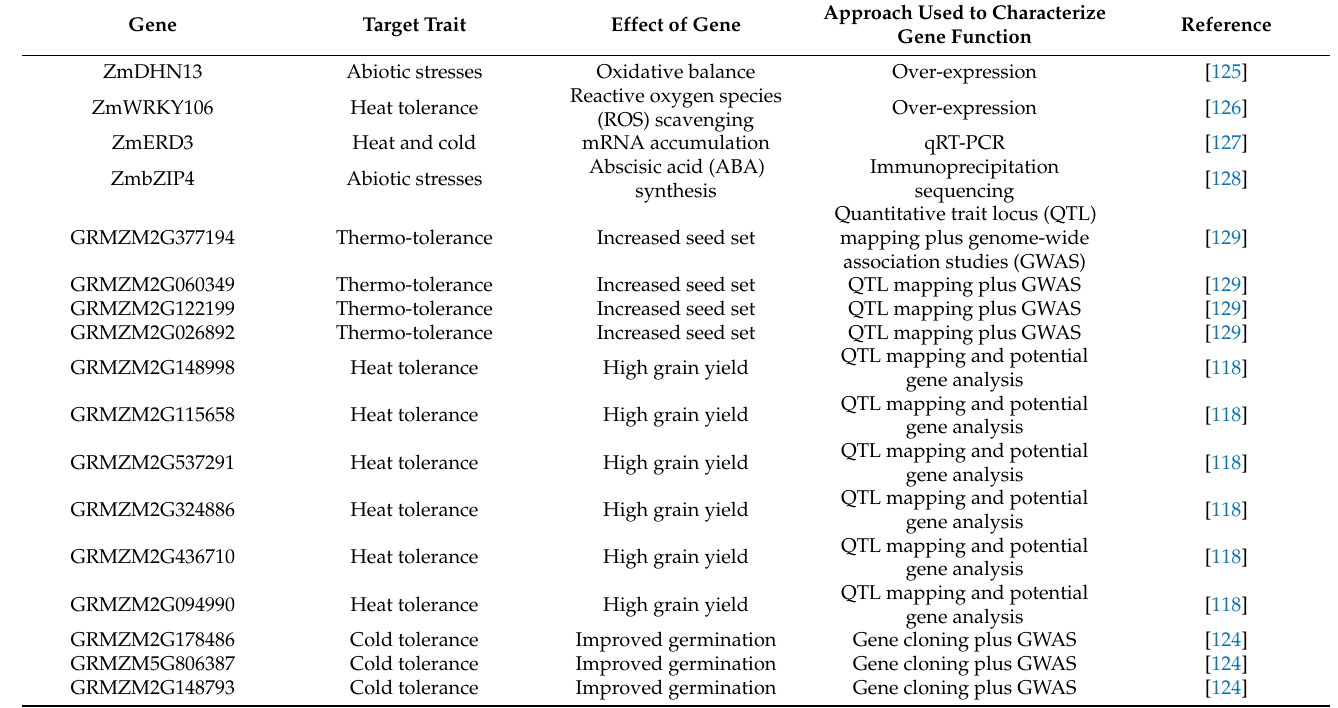
Table 5. Potential genes related to temperature stress tolerance in maize. Target Trait Effect of